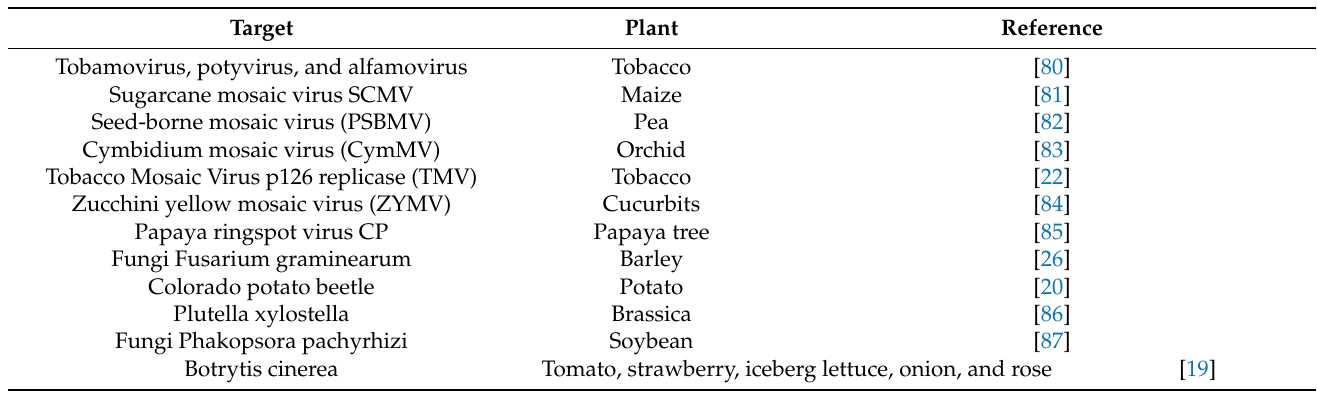
Table 1. Examples of RNAi and microRNAs applications in biotic and abiotic stress, their related references.